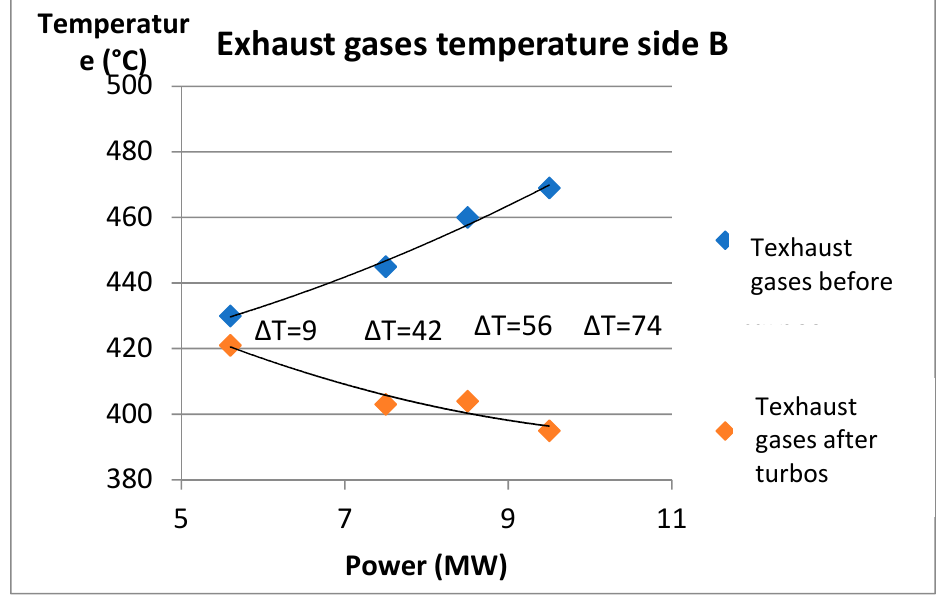
Figure 19. Analysis of the temperature of the exhaust gases of Side B before and after turbos as a function of the power set point.